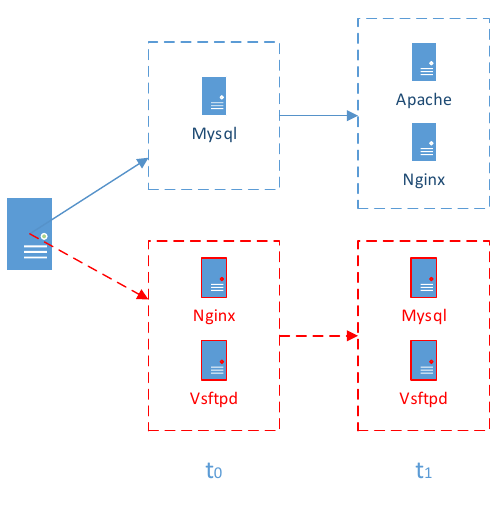
Figure 3. Changeable services.